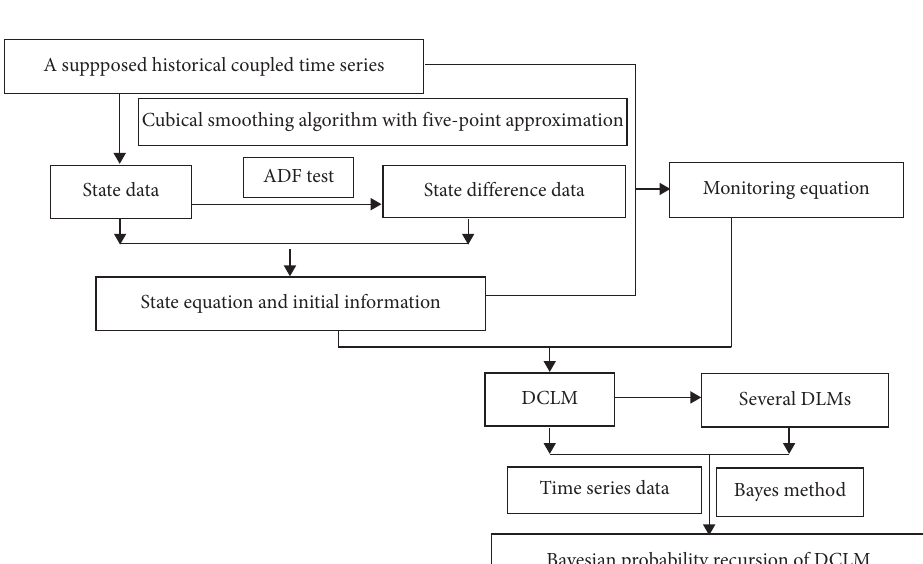
Figure 1: Main flowcharts of this paper.